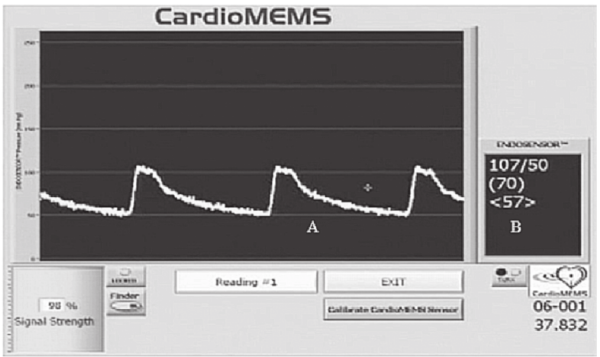
Figure 2 – Pressure wave and levels measured by the sensor during Reading 1. A . Pressure wave within the aneurysm sac. B . Various pressure levels within the sac. From top to bottom: systolic/diastolic, mean, and pulse